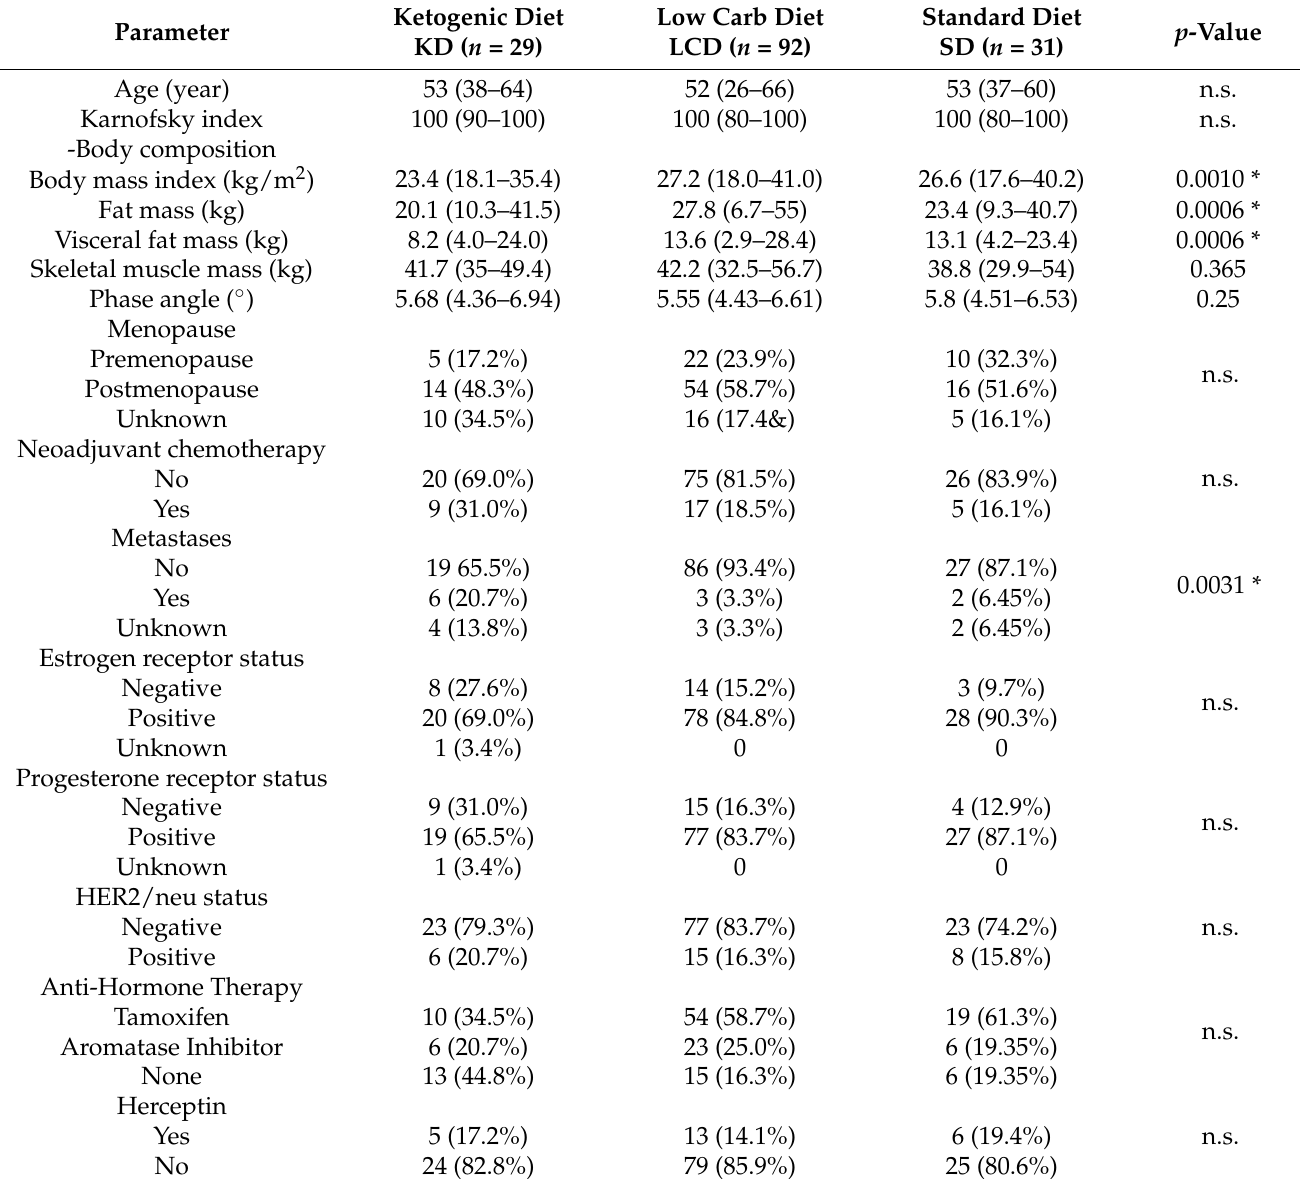
Table 1. Baseline characteristics of the patients comprising the three intervention